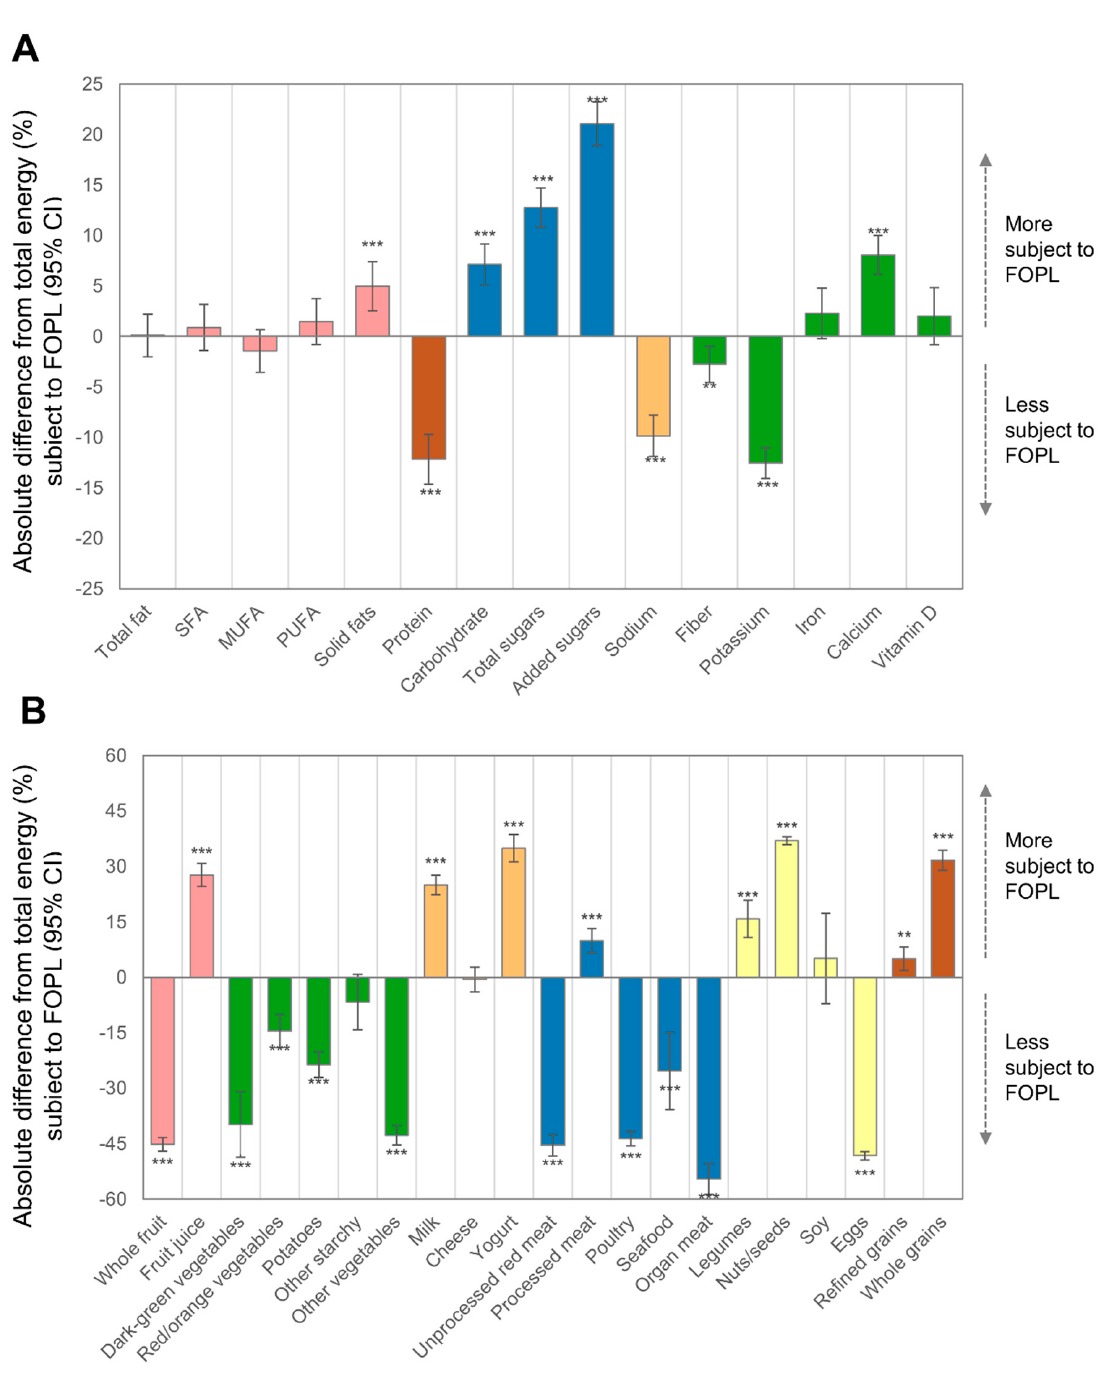
Figure 2. Absolute differences in proportion of macronutrients and micronutrients ( A ) and food groups ( B ) subject to FOPL within the diet of US population age ≥ 2 year ( n = 7121), 2017–2018. Asterisks indicate p -value comparing absolute difference to total energy where 56.6% is subject to FOPL; *** p < 0.001; ** 0.001 < p < 0.01. For example, 44.5% of protein consumed is subject to FOPL so the absolute difference compared to energy (56.6%) is − 12.2% (95% CI − 14.7, − 9.7, p < 0.001). SFA stands for saturated fatty acids, MUFA stands for monounsaturated fatty acids and PUFA stands for polyunsaturated fatty acids.